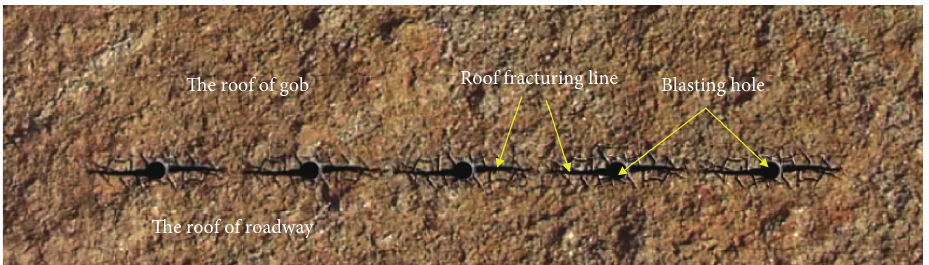
Figure 17: Fracture propagation due to